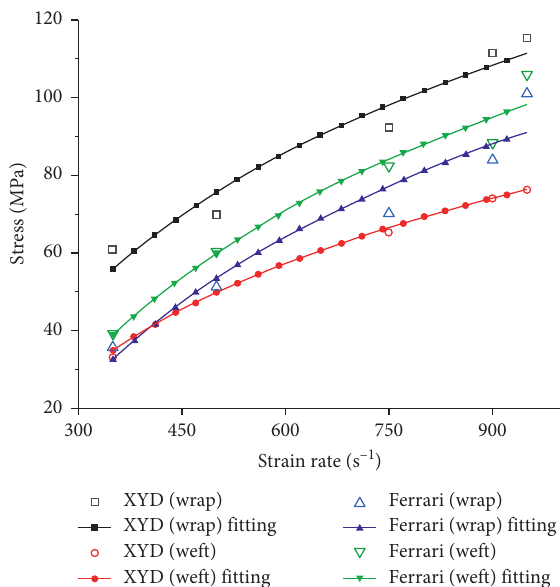
Figure 7: Ultimate tensile strength in different strain rates.